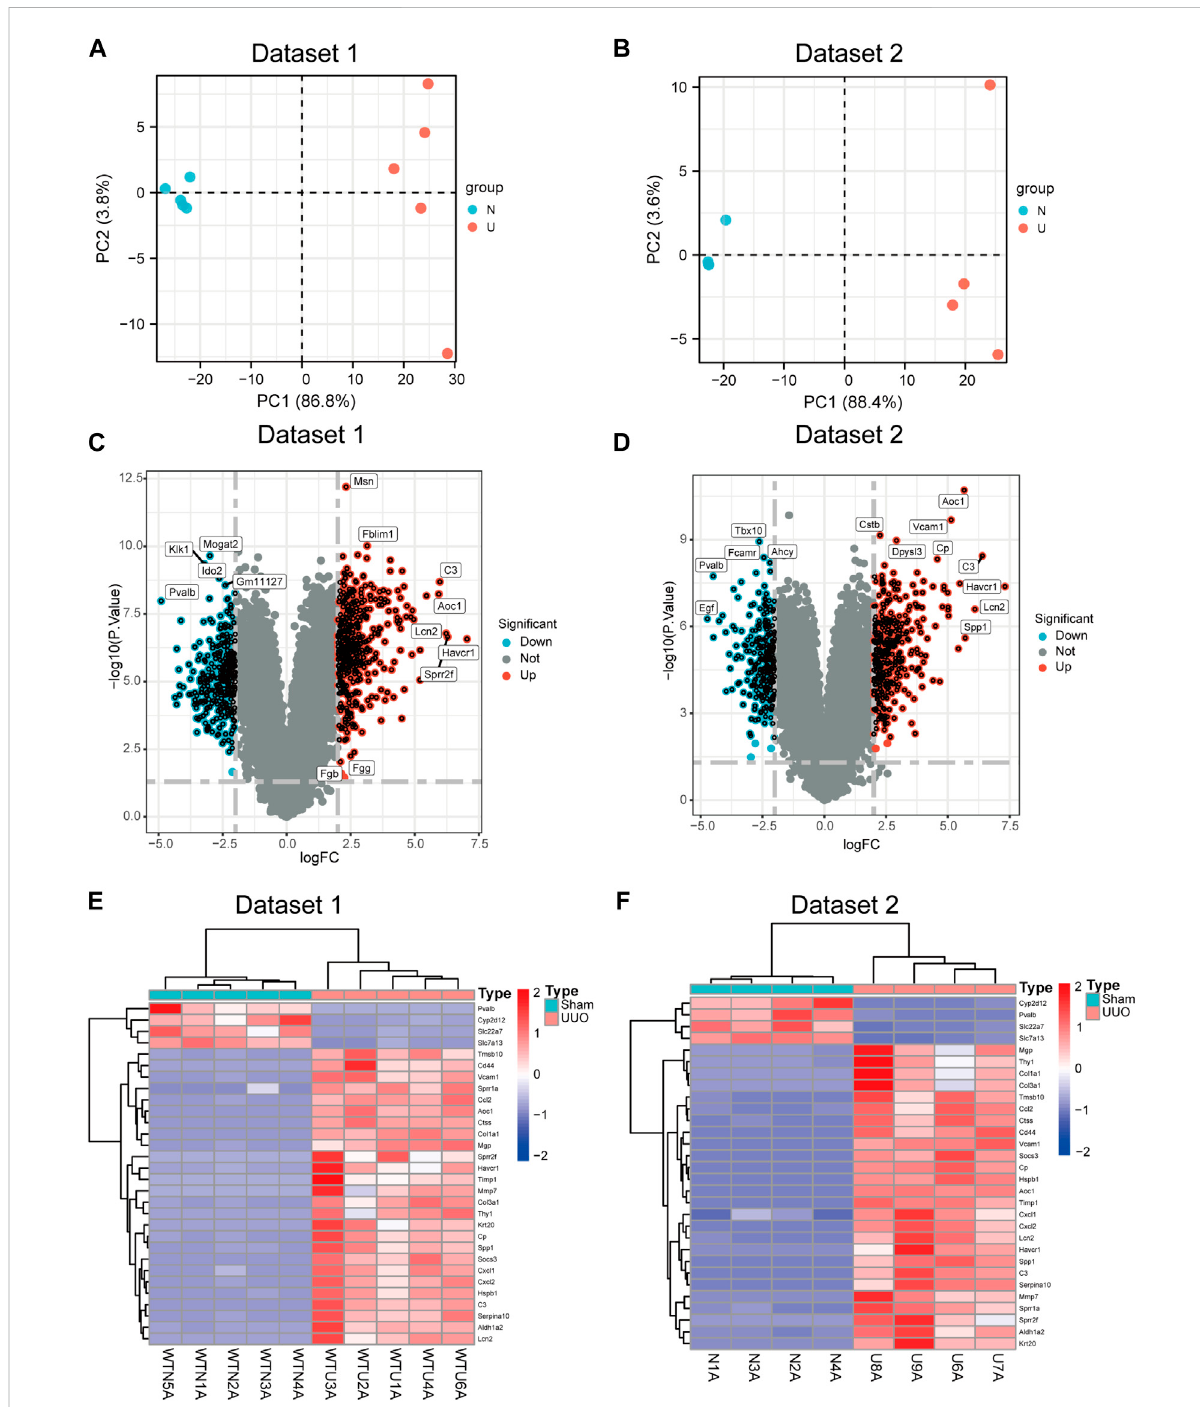
FIGURE 2 DEGs were identi fi ed between sham and UUO. (A) Principal component analysis (PCA) plot of dataset 1. (B) PCA plot of dataset 2. (C) Volcano plot of DEGs in dataset 1. (D) Volcano plot of DEGs in dataset 2. (E,F) Heatmap showing the gene expression of top 30 DEGs in dataset 1 (E) and in dataset 2 (F) Each row represents a gene and each column represents a